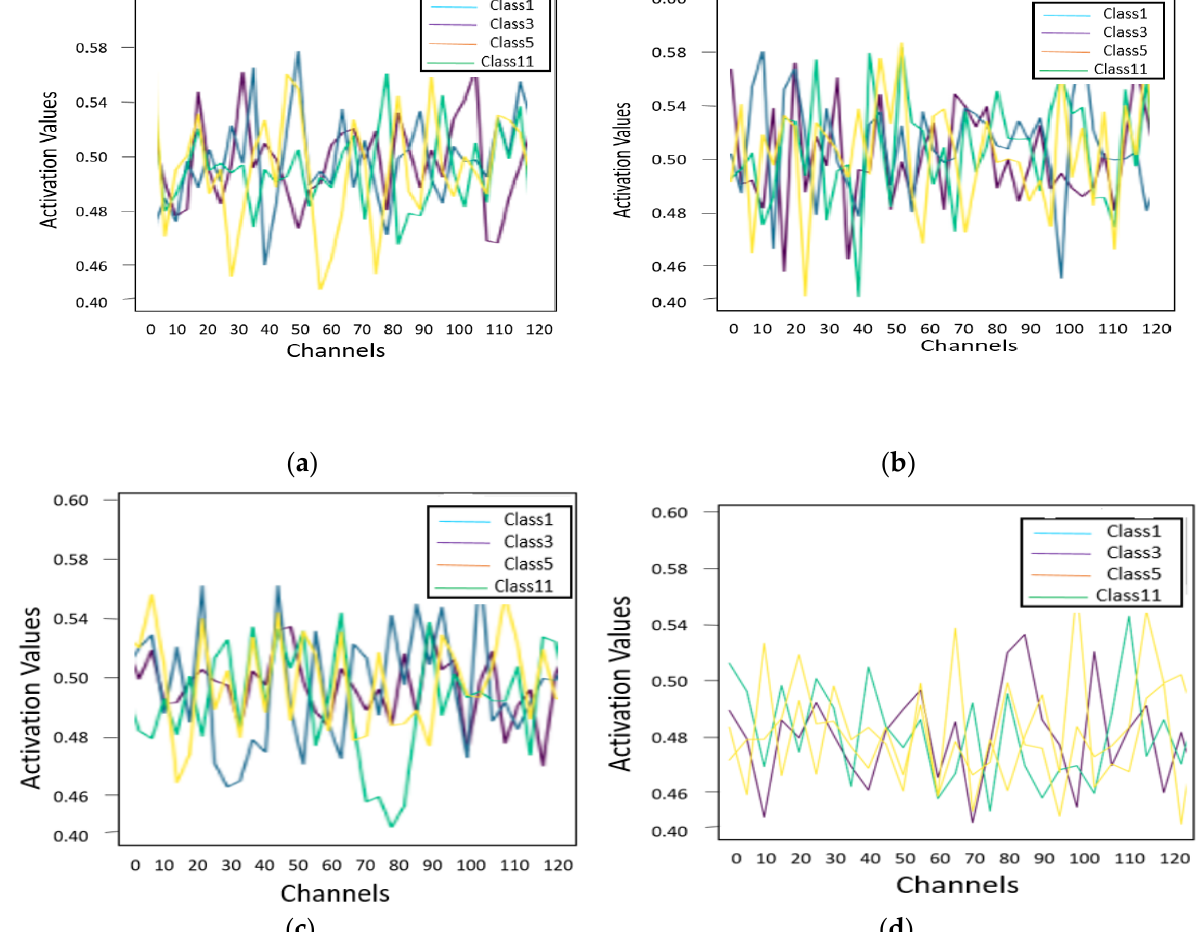
Figure 14. Illustration of the spectral behavior of four different classes in SE blocks: ( a ) SE-1; ( b ) SE-2; ( c ) SE-3; and ( d ) SE-4.